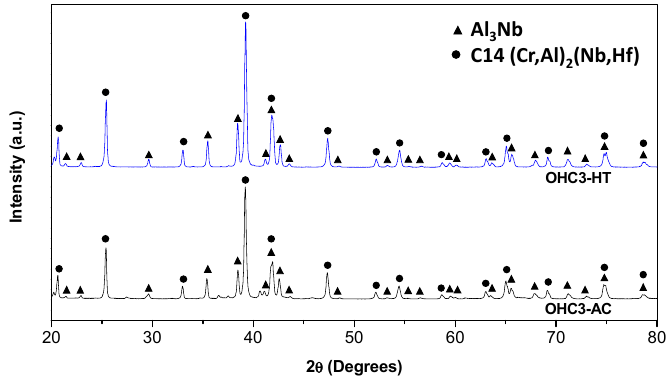
Figure 2. Powder X-ray diffractograms of the alloy OHC3 in the cast and heat-treated conditions.